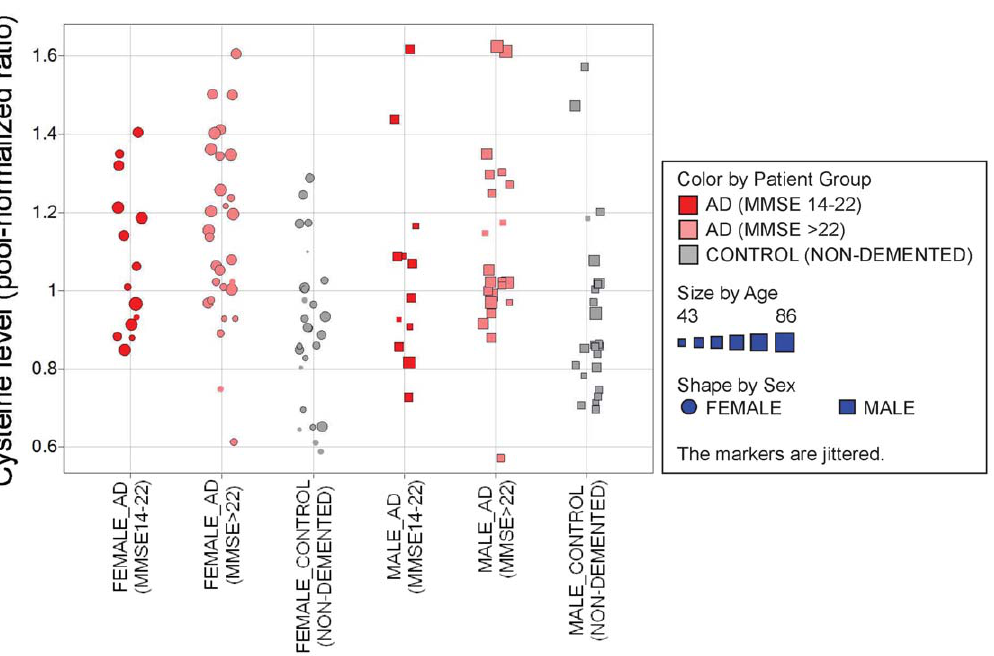
doi:10.1371/journal.pone.0031501.g003